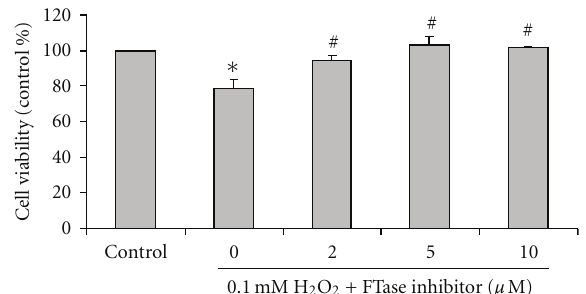
Figure 3: E ff ect of farnesyltransferase (FTase) inhibitor, FTI-277, on H 2 O 2 -induced reduction in cell viability in SH-SY5Y cultured cells. SH-SY5Y cells were treated with 2.0, 5.0, and 10.0 μ M FTI-277 for 3 hours prior to incubation with 0.1mM H 2 O 2 for another 24 hours. Cell viability was assessed using MTT assay and presented as percentage of untreated (0mM) control cells. The results are expressed as mean ± SEM of four independent experiments. The ANOVA was performed for statistical analysis ( ∗ P < . 05 compared with control and # P < . 05 compared with H 2 O 2 -treated